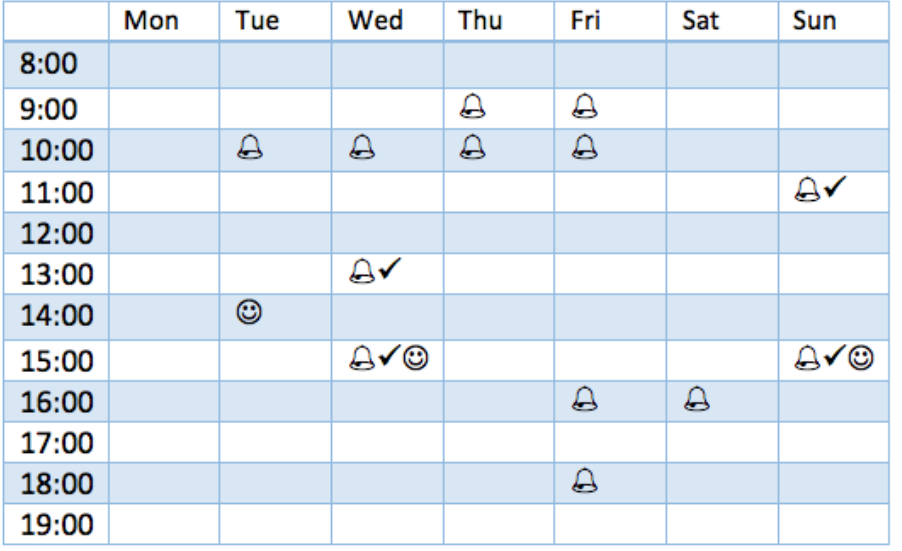
Figure 5. The reminder delivery and corresponding behaviors of user No. 2 in the intervention week, where a bell represents one reminder, a tick represents one short-term reaction (clicking the reminder pop-up), and a smile represents one physical